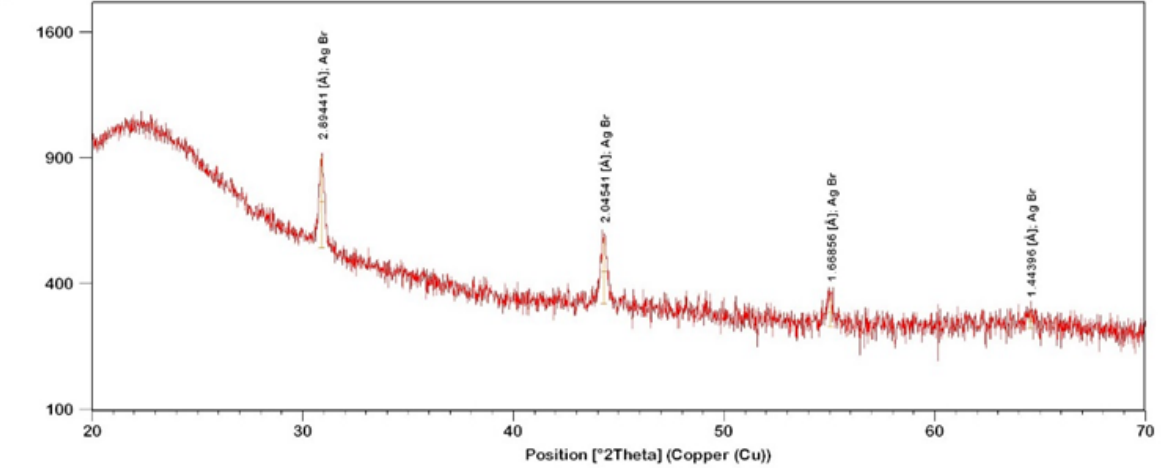
Figure 5. X-ray diffraction spectrum Sil–Im (2)—pre-equilibrated with a solution of Ag(I) in 0.1 M HNO 3 .